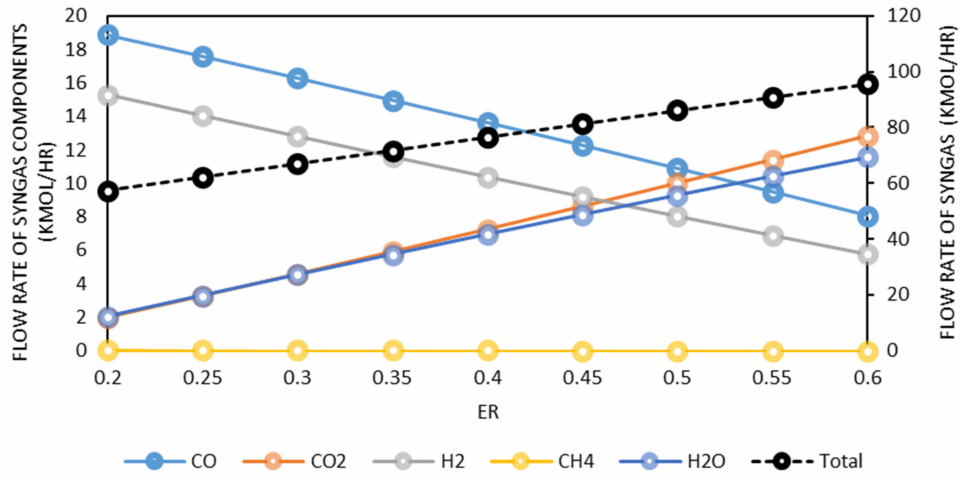
Figure 6. E ff ect of equivalence ratio (ER) on molar flow rates of syngas constituents.